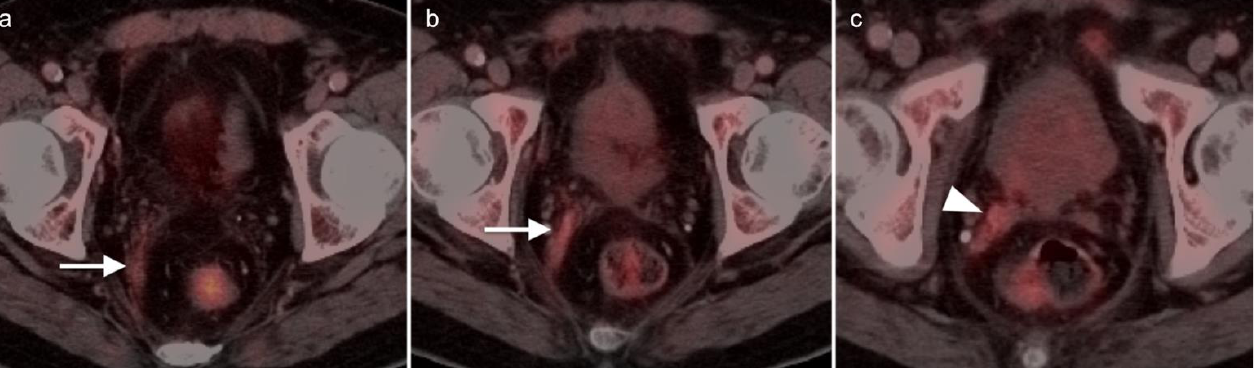
Figure 34. [ 18 F]-fluciclovine PET-CT in a post prostatectomy patient showing recurrent tumor in the right neurovascular pedicle (( c ), white arrowhead), extending along the right mesorectal fascia (( a , b ), white arrows), representing a path of perineural spread along the hypogastric plexus. Nodal spread of disease is considered regional if it involves branches of the internal or external iliac vessels below the bifurcation, as well as presacral, periprostatic and perirectal nodes. Common iliac and periaortic/pericaval nodes, to the level of the renal vessels, represent the next order of spread, and are considered non-regional nodes. In- volvement of upper abdominal retrocrural as well as left medial supraclavicular nodes typically herald distant metastatic spread. It is critical to recognize lumbar, celiac, sacral and stellate ganglia, which are typically mildly PET-positive both on [ 18 F]-fluciclovine and [ 68 Ga]- or [ 18 F]-PSMA PET-CT and can be easily confused with early involvement of lymph nodes. These ganglia are typically bilateral structures but may not be perfectly symmet- rical (Figure 35).